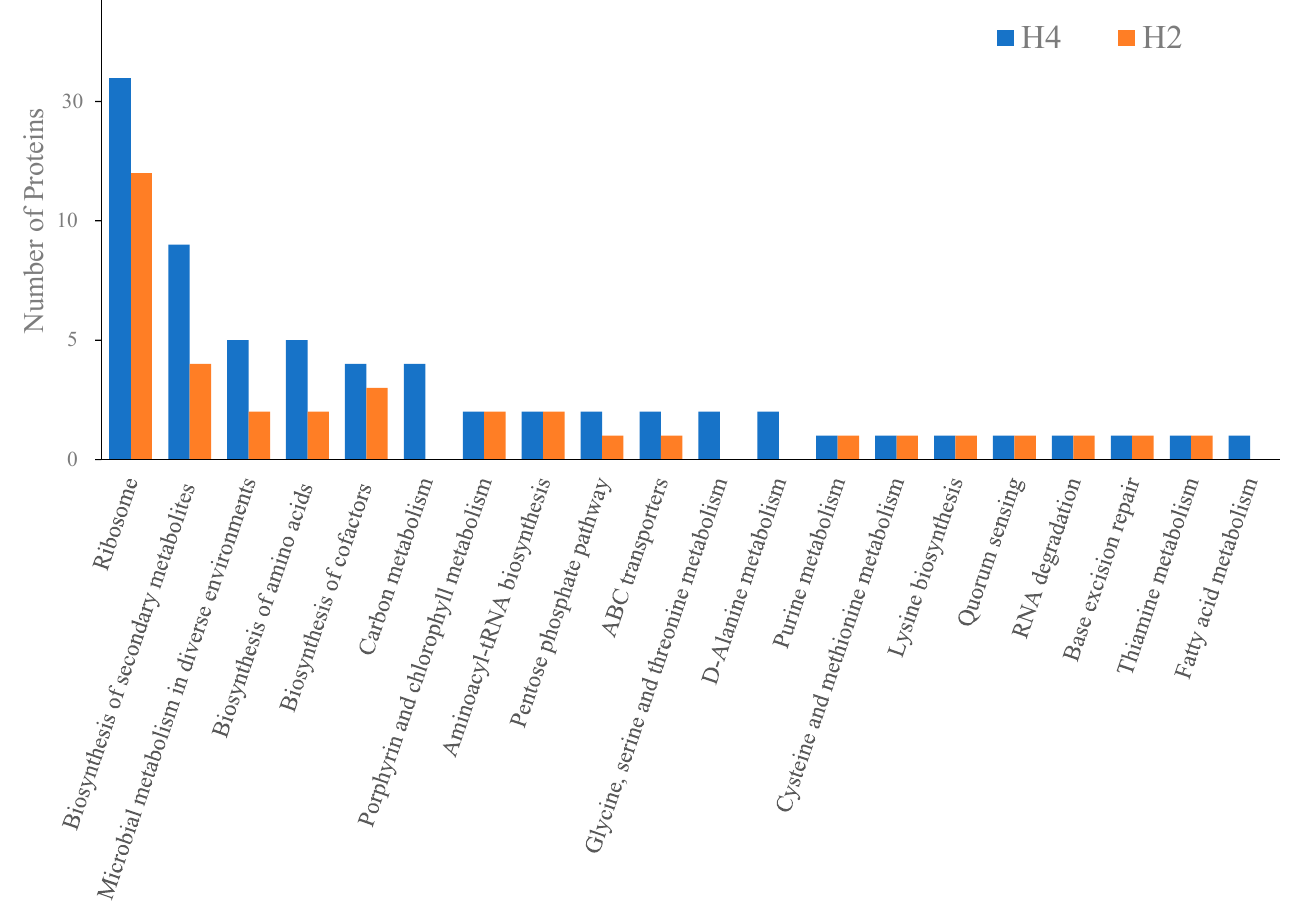
Figure 4. The top 20 pathways using KEGG pathway analysis of differentially expressed proteins (DEPs) in L. monocytogenes under the H2 and H4